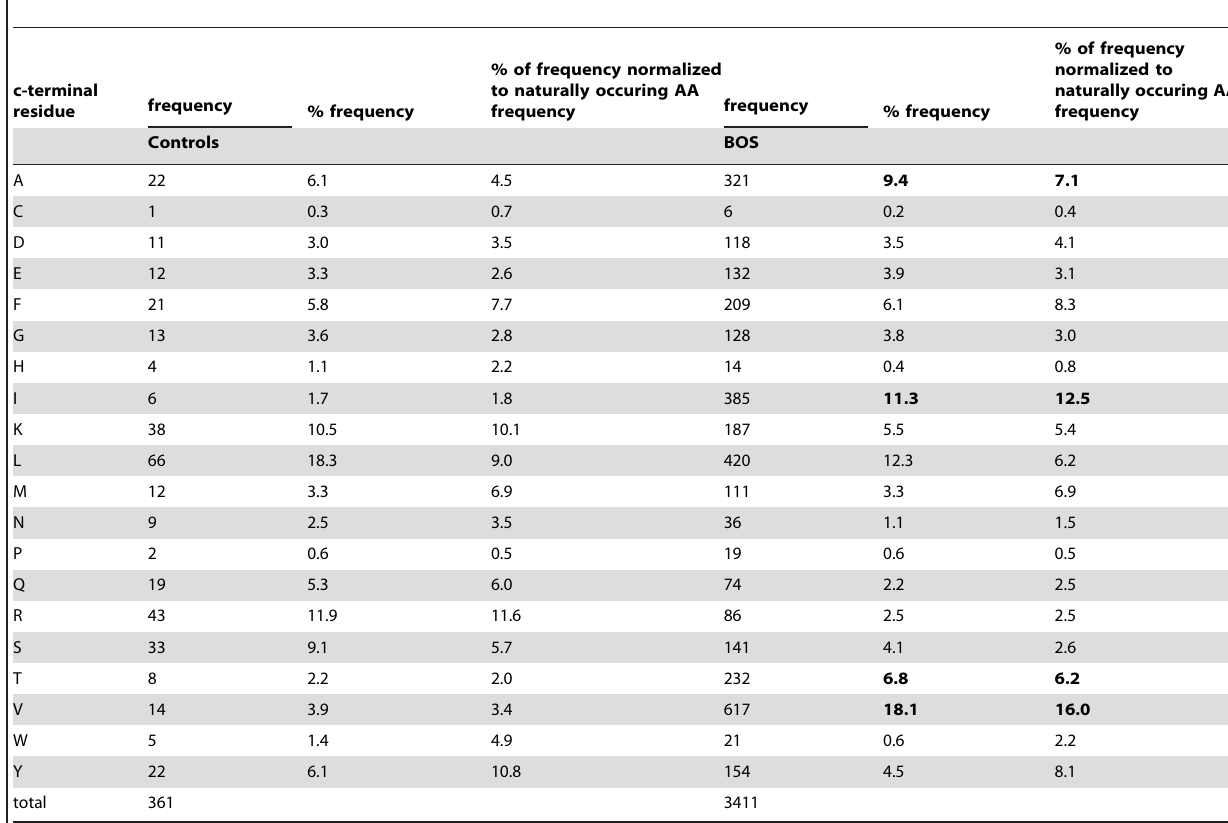
Table 2. C-Terminal amino acid comparison of unique endogenous peptides identified in BALF of transplant patients, control compared to